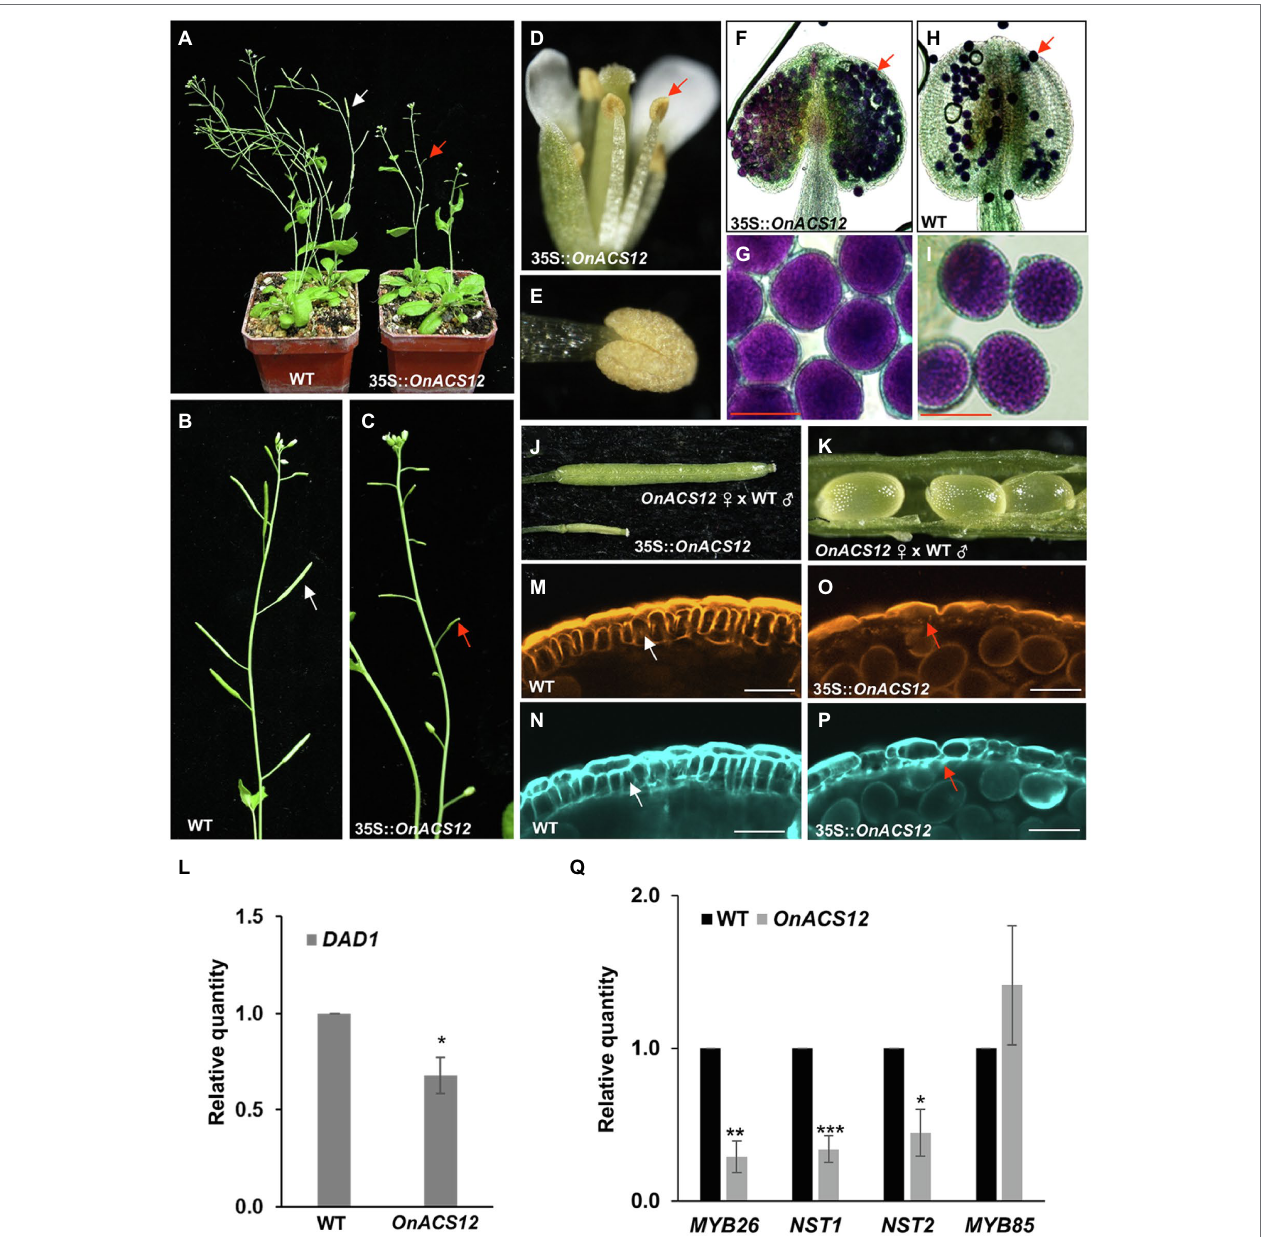
FIGURE 3 | Analysis of the indehiscent anther phenotype and detection of gene expression in 35S:: OnACS12 Arabidopsis . (A) A 52-day-old 35S:: OnACS12 plant produced short siliques (red arrow on the right), whereas the wild-type plant produced normal elongated siliques (white arrow on the left). (B,C) Wild-type inflorescence showing elongated siliques (white arrow in B ) and a 35S:: OnACS12 plant with short siliques (red arrow in C ). (D) A 35S:: OnACS12 flower with an indehiscent anther (arrow). (E) Close-up view of an indehiscent anther from (D) . (F–I) Pollen grain viability analysis of 35S:: OnACS12 male-sterile anthers via Alexander staining. Anthers of 35S:: OnACS12 (F) and wild-type (H) Arabidopsis had similar viable pollen grains (arrows). Close-up of pollen grains with similar shapes and normal viability from 35S:: OnACS12 (G) and wild-type (I) plants. Bar = 20 μ m. (J) The normal elongated silique of a 35S:: OnACS12 plant after cross- pollination with wild-type pollen (top) along with a short 35S:: OnACS12 silique without pollination (bottom). (K) Normal seed development was observed in a 35S:: OnACS12 silique after cross-pollination. (L,Q) The mRNA levels were determined via real-time quantitative PCR. Total RNA isolated from 35S:: OnACS12 transgenic plants and wild-type Columbia plants was used as a template to detect the expression of DAD1 (L) , MYB26 , NST1/2 , and MYB85 (Q) . The transcript levels of these genes were determined using two to three replicates and were normalized to UBQ10 . The expression of each gene in the transgenic plants is given relative to that of the wild-type plant, which was set at 1. The error bars represent SDs. The asterisks indicate a significant difference from the WT value (* p < 0.05; ** p < 0.01; and *** p < 0.001). Statistical analysis was conducting using two-tailed Student’s t -tests. (M–P) Confocal laser-scanning microscopy (CLSM) of anther cell walls in 35S:: OnACS12 (O,P) and wild-type (M,N) plants. The anthers were double stained with auramine O for lignin, indicated in orange (M,O) , and calcofluor white for cellulose, indicated in cyan (N,P) . Secondary thickening is visible in the endothecium (arrow) of the wild-type anthers (M,N) and is absent in 35S:: OnACS12 anthers (arrow; O,P ). Bar = 25 μ